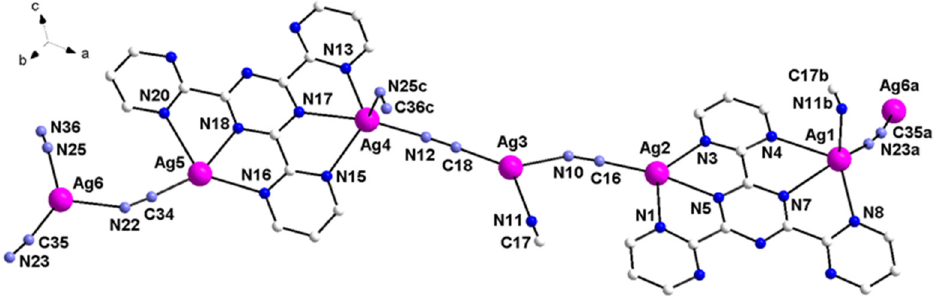
Figure 2. Asymmetric unit of compound 2 . Symmetry codes: a = 1 + x , 3/2 − y , ½ + z ; b = 2 − x , − y , 1 − z ; c = 1 − x , 2 − y , 1 − z .